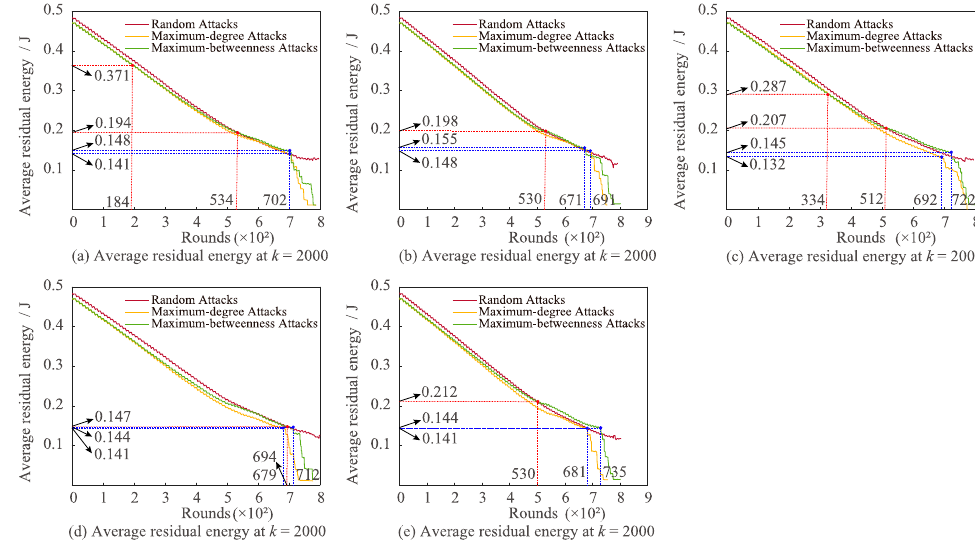
Figure 7. Effects of changing k on average residual energy for varied attacks.